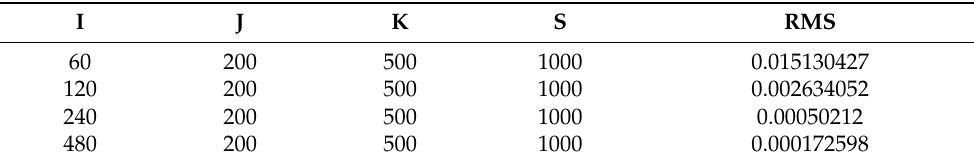
Table 1. Convergence for different mesh sizes along the oX axis.